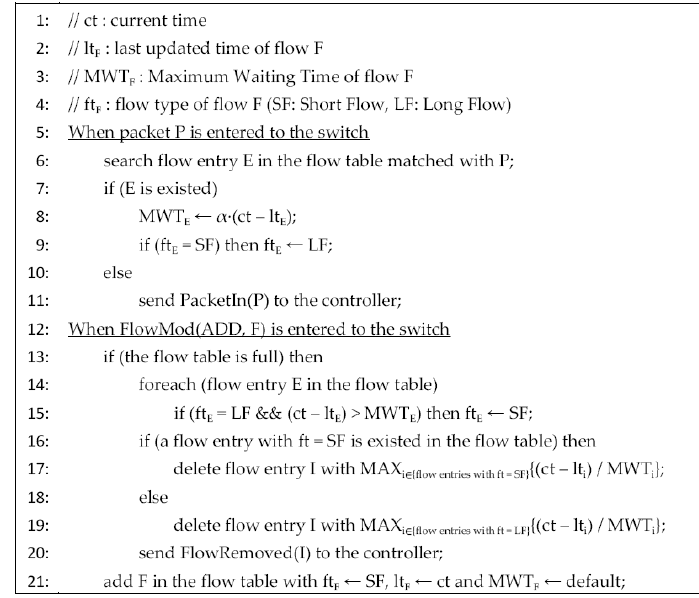
Figure 5. Pseudo code of the SFF scheme.